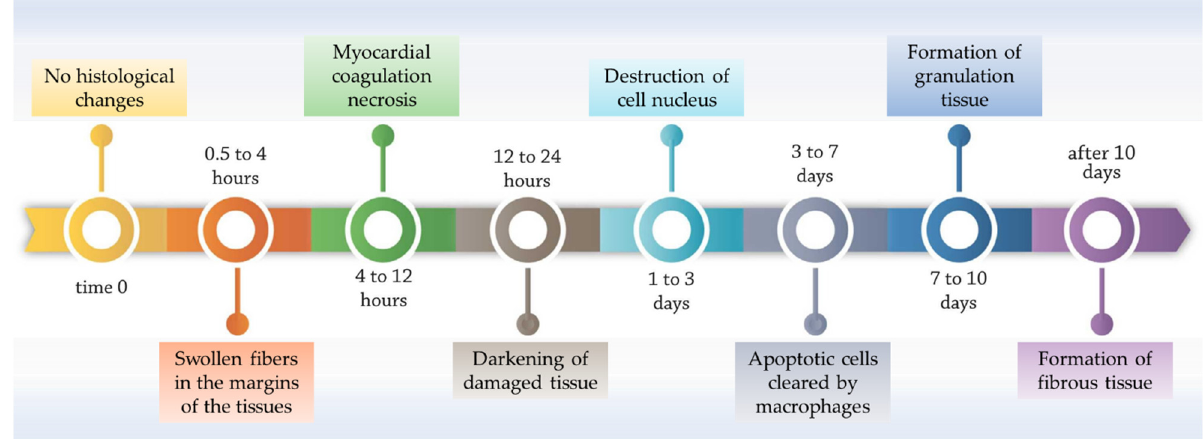
Figure 1. Histological changes after MI on heart tissue, including the period of 0–10 days. Adapted from [7] .